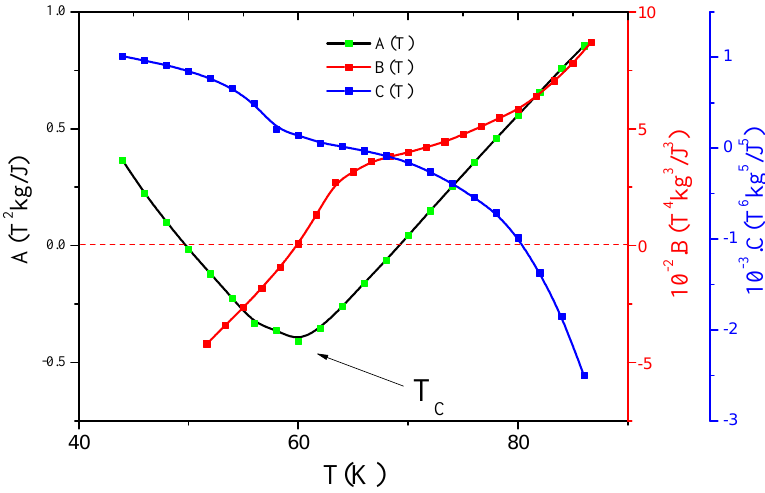
Figure 7. Landau parameter A (T 2 kg/J) (black y -axis), B (T 4 kg 3 /J 3 ) (red y -axis), and C (T 6 kg 5 /J 5 ) (blue y -axis) plotted against temperature around the T C for SmNi 3 sample.